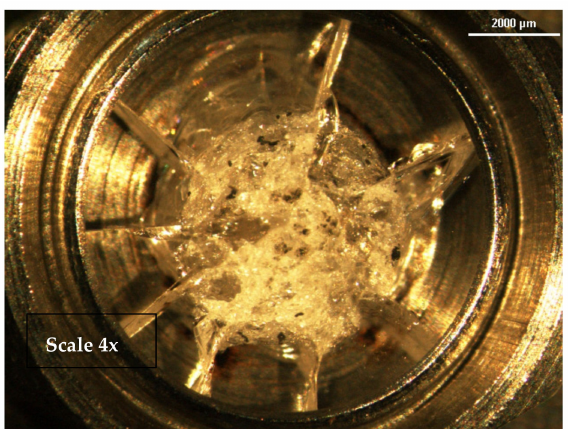
Figure 15. Lower JB on z axis after the test, AISI 316